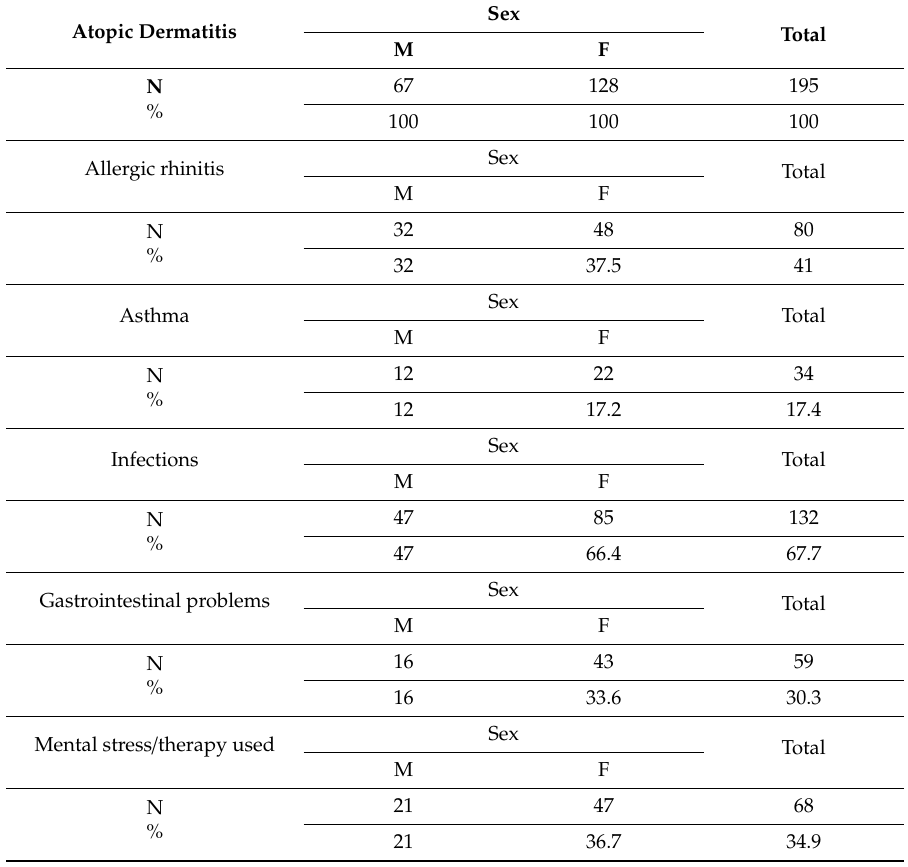
Table 2. The incidence of atopic dermatitis and comorbidities in relation to the sex of the patients. Atopic